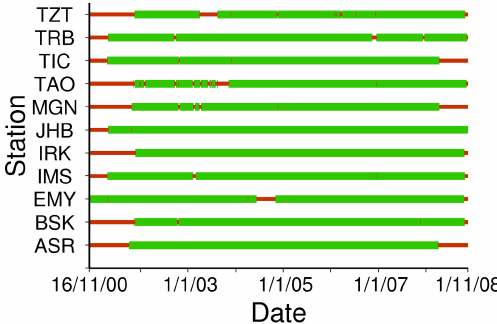
Fig. 2. Availability of daily precipitation values at the eleven test sites. Available dates are marked in green and missing dates are marked in